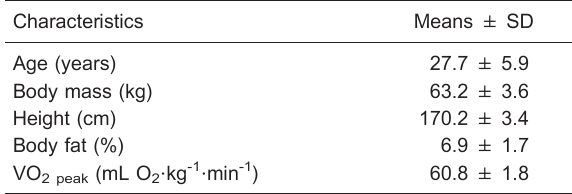
Table 1. Subject characteristics.